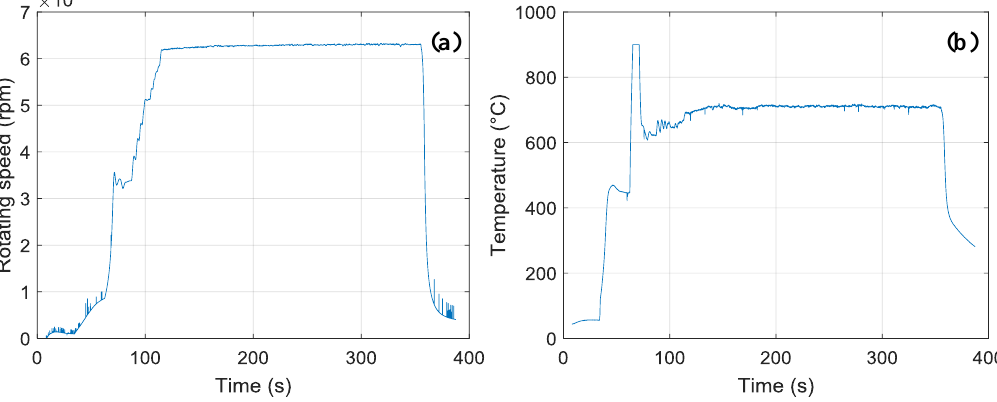
Figure 5. Engine rotation speed and temperature. ( a ) Time-dependent rotating speed of the engine; ( b ) Time-dependent temperature of the outlet wall.